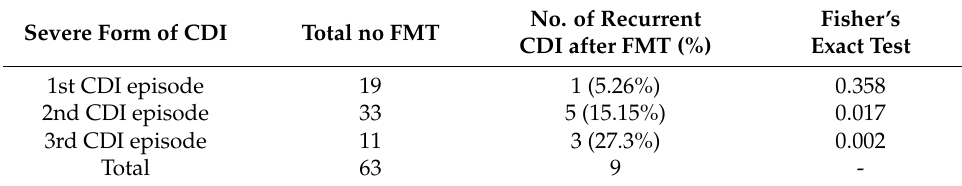
Table 2. Recurrence risk in severe